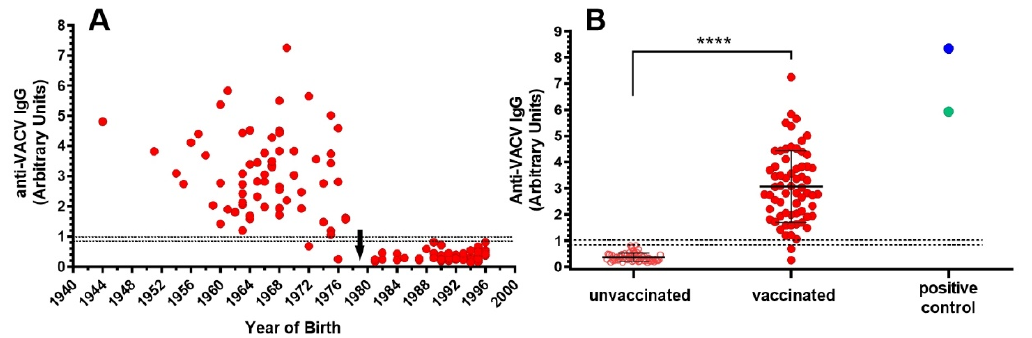
Figure 6. Detection of vaccinia virus IgG antibodies in serum samples of 130 individuals born before and after the completion of smallpox vaccination in Brazil. Detection was performed by ELISA using purified inactivated VACV-Wyeth clone A111 as antigen. Results for each serum are represented by individual dots and expressed as arbitrary units. ( A ) Distribution of anti-VACV IgG values according to the year of birth. Black arrow points to 1979, when smallpox vaccination was ended in Brazil. ( B ) Serological response to VACV-Wyeth was plotted according to the presumed vaccination status. Individuals born before 1979 were considered vaccinated and individuals born after 1979 were considered unvaccinated. The blue circle refers to a laboratory worker recently and repeatedly vaccinated with the smallpox vaccine. The green circle corresponds to a pool of two convalescent sera from laboratory workers accidently infected with VACV. Dotted lines indicate the upper and lower limits of the test cut-off. **** p < 0.0001 (Mann–Whitney).